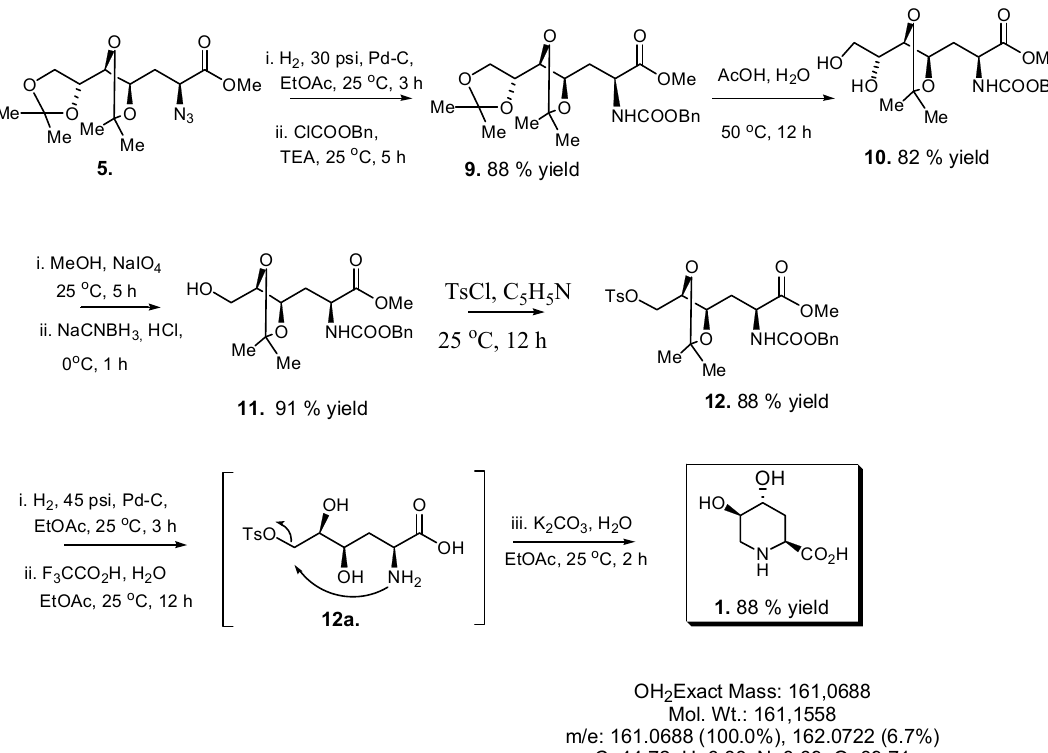
Scheme 4. Synthesis of compound 1 from azide 5